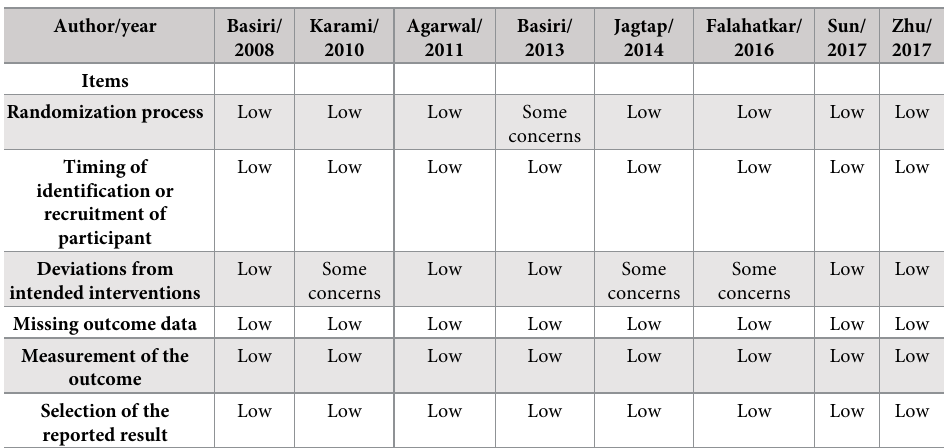
Table 3. Results of quality assessment of